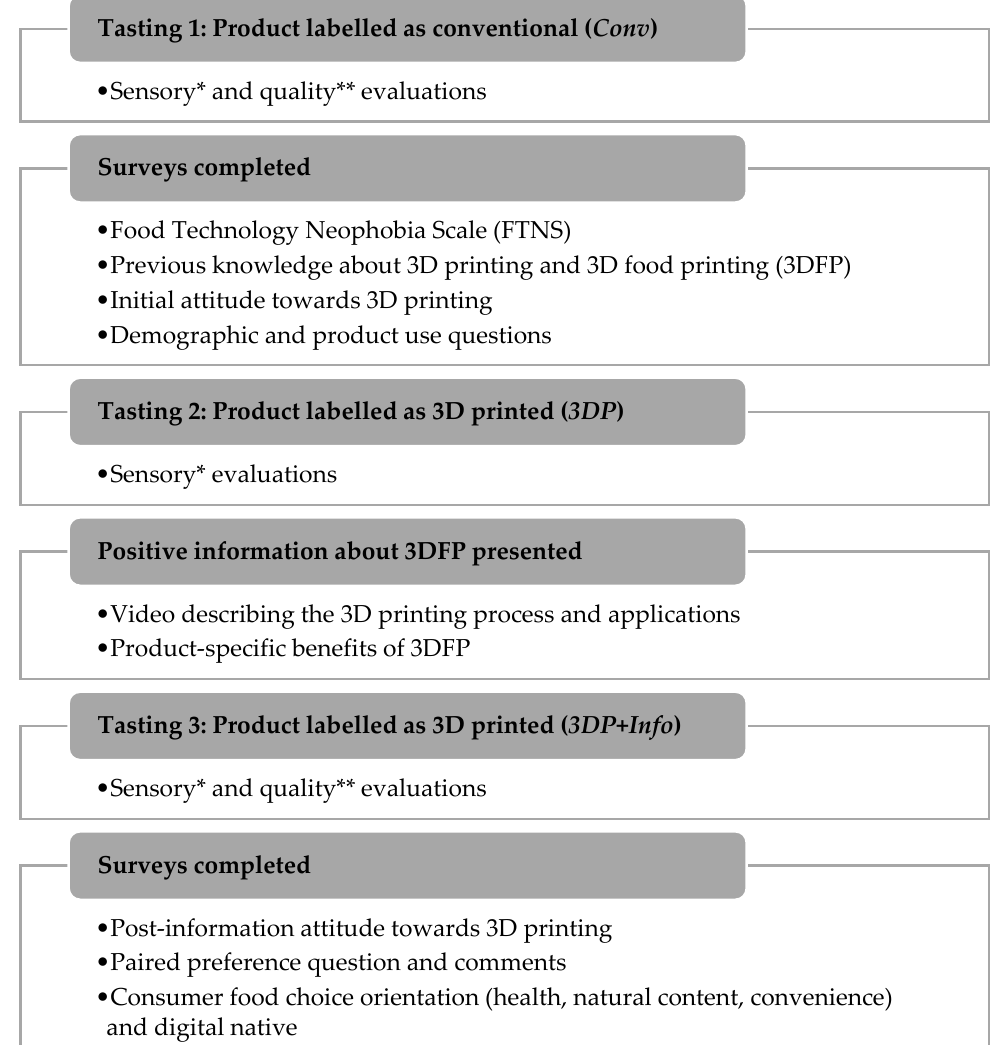
Figure 1. Study design for the assessment of study food products and survey completion. * Sensory evaluations: Overall liking and liking of appearance, aroma, flavor, texture on 9-point hedonic scales anchored with ‘dislike extremely” to “like extremely”. ** Quality evaluations: Agreement with high product quality on 5-point Likert scales anchored with “strongly disagree” to “strongly agree”.